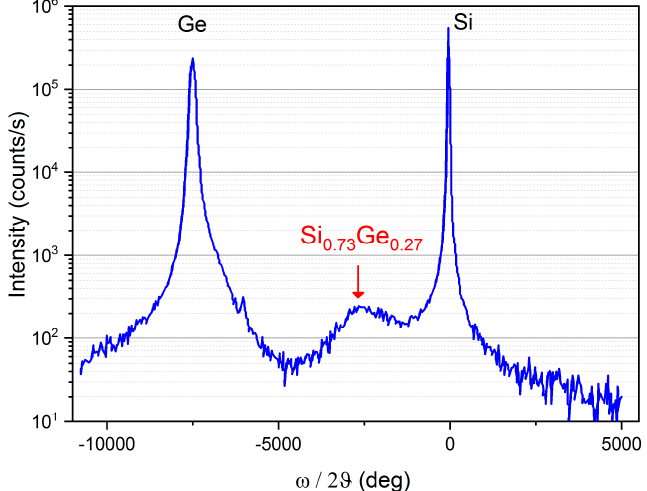
Figure 4. X-ray diffraction results of the 120 nm thick p + -Si 0.73 Ge 0.27 layer grown on Ge. The peak corresponding to Si 0.73 Ge 0.27 does not show well defined fringes due to layer relaxation.